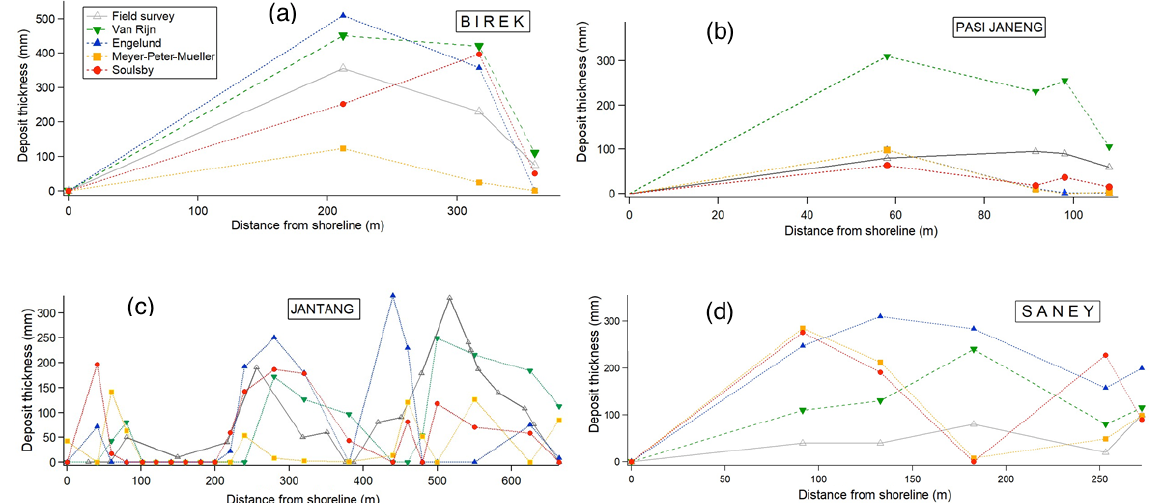
Figure 11. Comparison of tsunami deposit thickness results from the numerical models using four different sediment transport formulae and the field survey at Birek, Pasi Janeng, Jantang, and